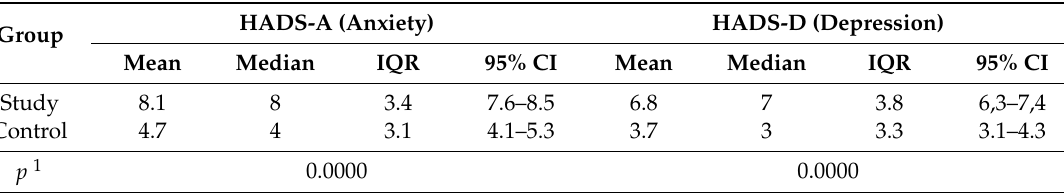
Table 2. Comparison of Hospital Anxiety and Depression Scale (HADS)-A and HADS-D between the study and control